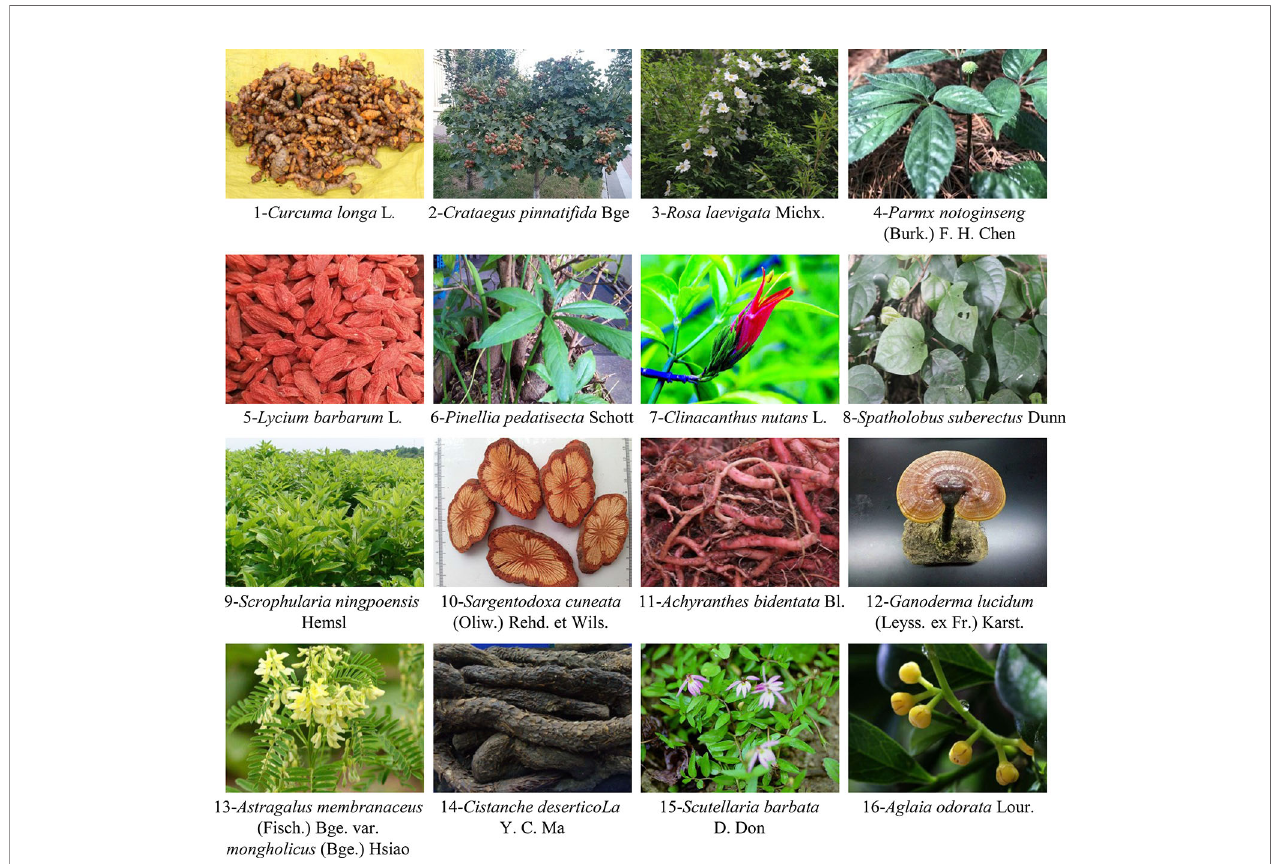
FIGURE 2 | Representative herbal images that may inhibit ischemic neuron apoptosis by regulating MPTP. Sixteen herbs are shown